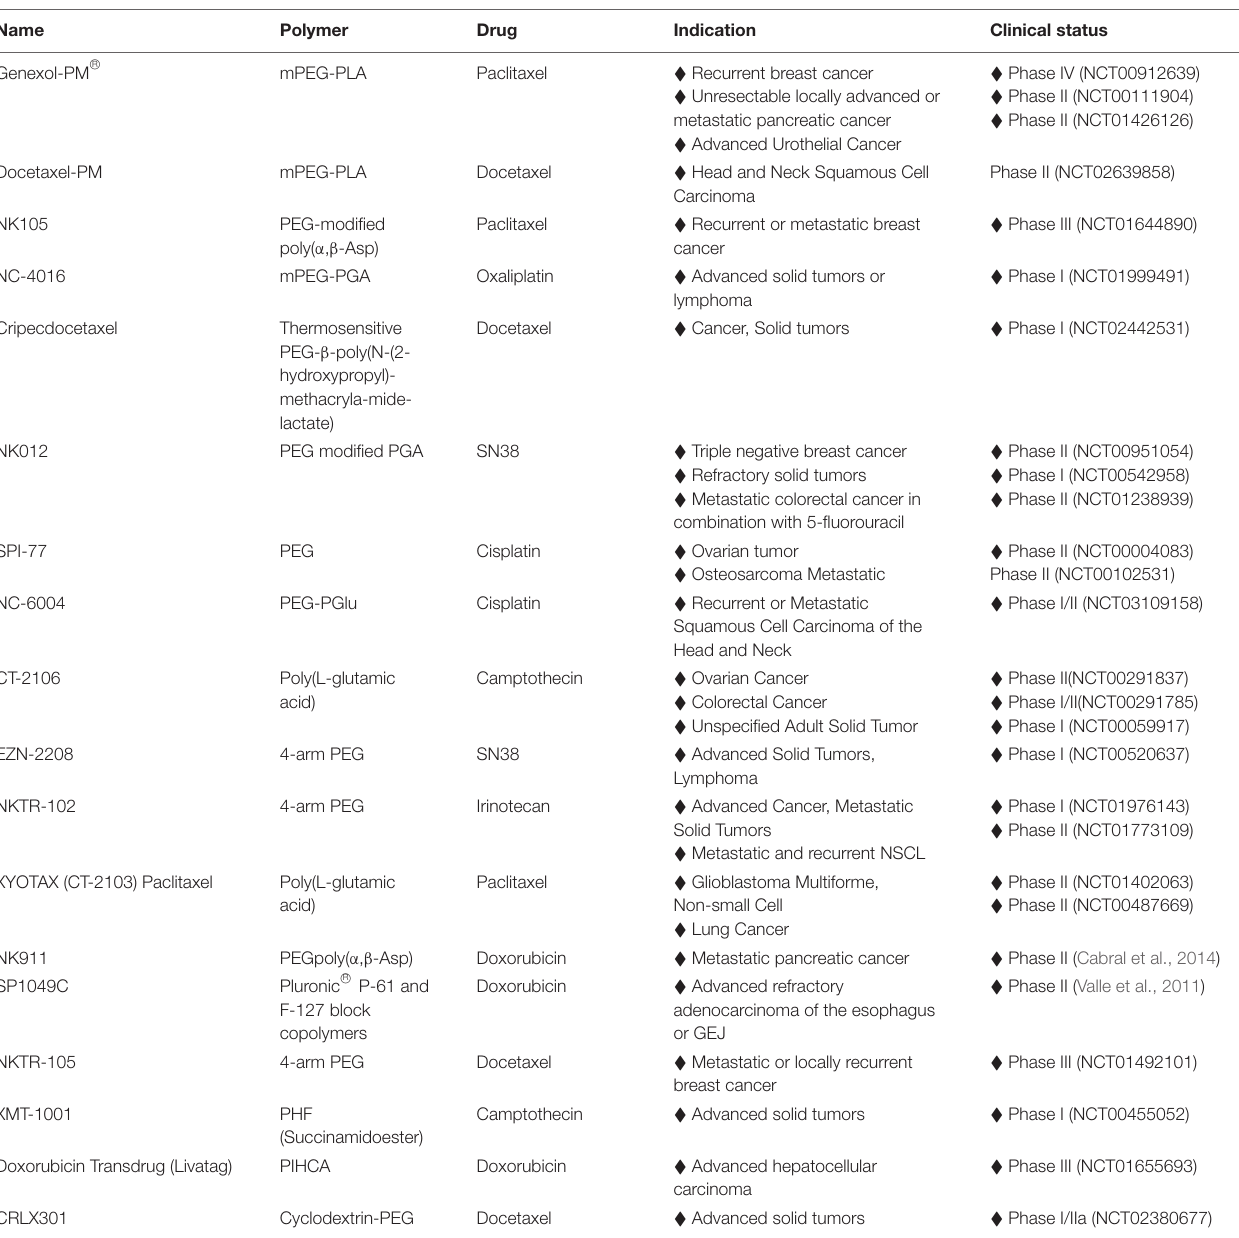
TABLE 2 | Clinical studies of polymeric delivery systems for cancer